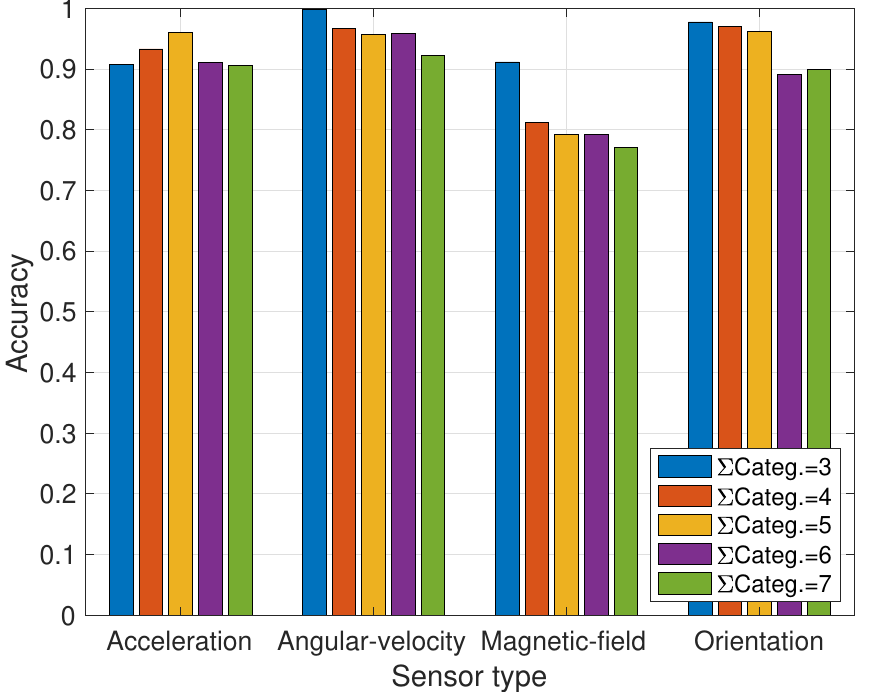
Figure 7. Classification accuracy versus sensor-type for accelerometer sensor as a function of the number of motion activities. No. of hidden units = 150, solver = ADAM, sample-rate =